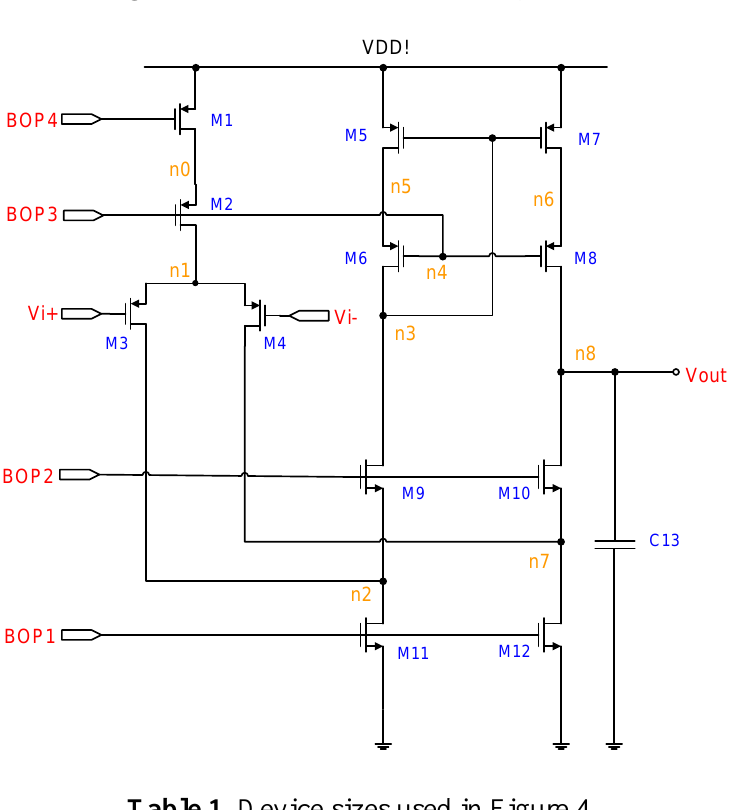
Figure 4. Schematic of the OP-amp circuit.